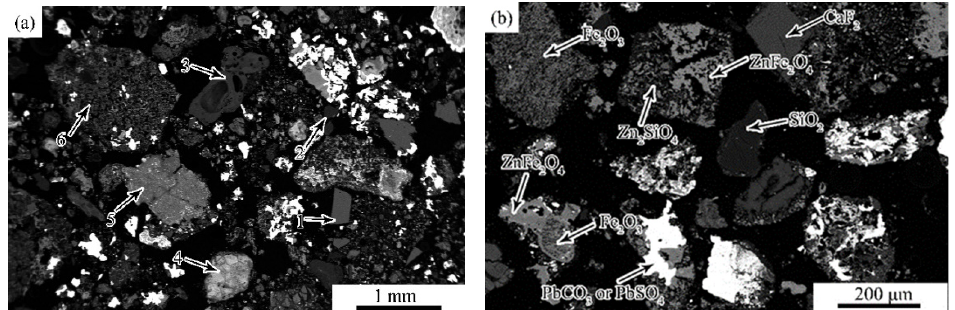
Figure 2. Backscattered electron images showing the morphology of the zinc calcine found at the Doulingxia site. ( a ) Low magnification, ( b ) tiny particles.